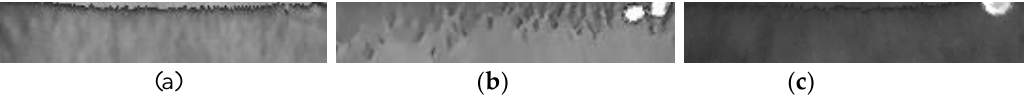
Figure 16. Examples of iris recognition areas of di ff erent iris libraries. ( a ) Iris recognition area of Figure 2b, ( b ) iris recognition area of Figure 2d, ( c ) iris recognition area of Figure